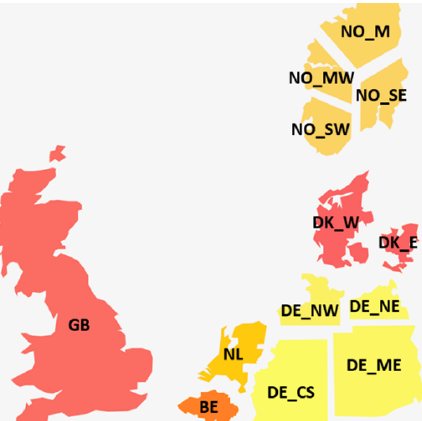
Figure 2. The North Sea region countries in focus (the regional split refers to the project-based and meshed grid scenarios); figure is taken from Koivisto et al. (2020). The north region of NO (NO_N) is not shown in the graph but included in the aggregated